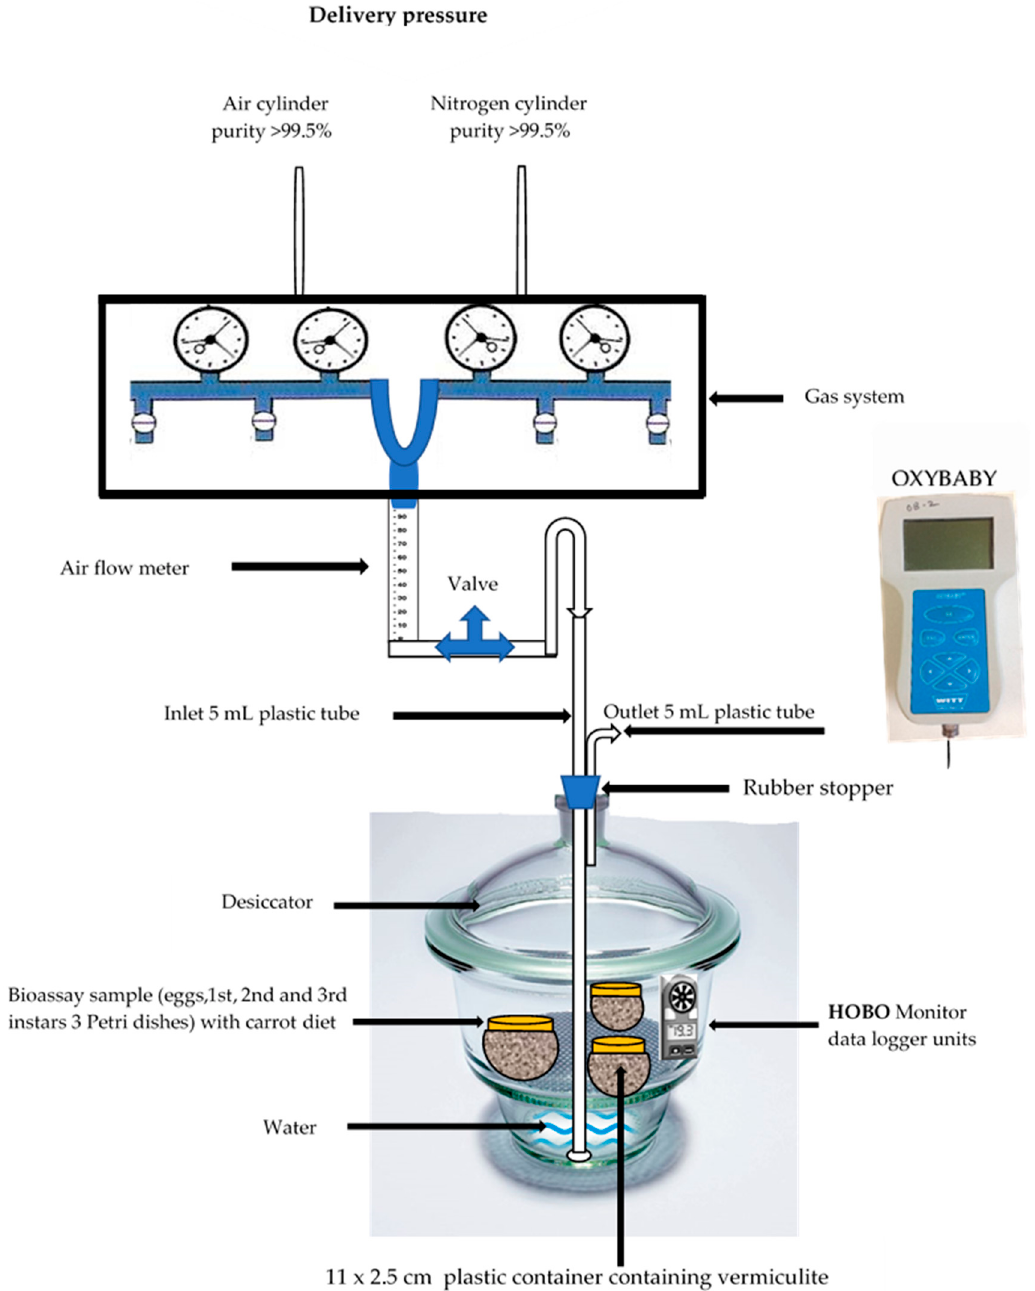
Figure 1. Schematics of low-oxygen treatment experimental setup.